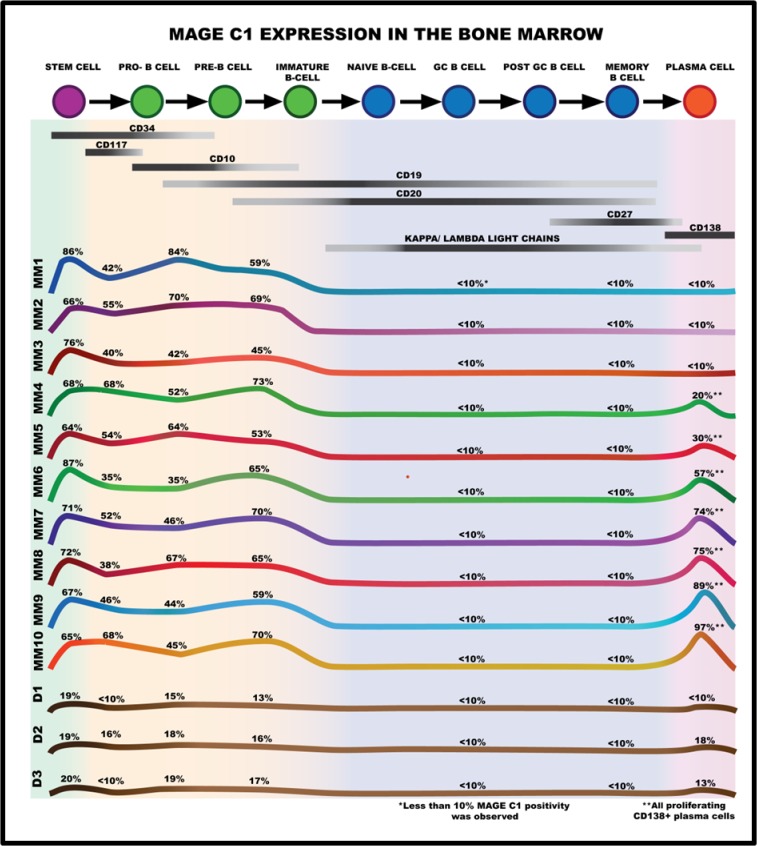
Schematic representation of the co-expression of B cell maturation markers and MAGE C1 in the relevant BM B-lymphocyte sub-populations of MM patients and donors.MAGE C1 expression was observed in the very early stages of B cell maturation involving the CD34+, CD117+, CD10+ and CD19+ cells (stem cells to early-mid immature B cells) in the BM, but was absent when light chain expression was expressed (naive and germinal centre B cells). Positive MAGE C1 expression was also observed in the proliferating plasma cell population, but not in the preceding CD27+ memory cells present in the BM. The percentage indicated is the number of cells in a specific cell population expressing MAGE C1 (as defined by a specific cell-surface antigen). MM BM samples are ordered according to increasing MAGE C1+ expression on the plasma cells. MM 1 to 10 as well as D1 to 3 indicates the different MM patient and donor profiles, respectively.